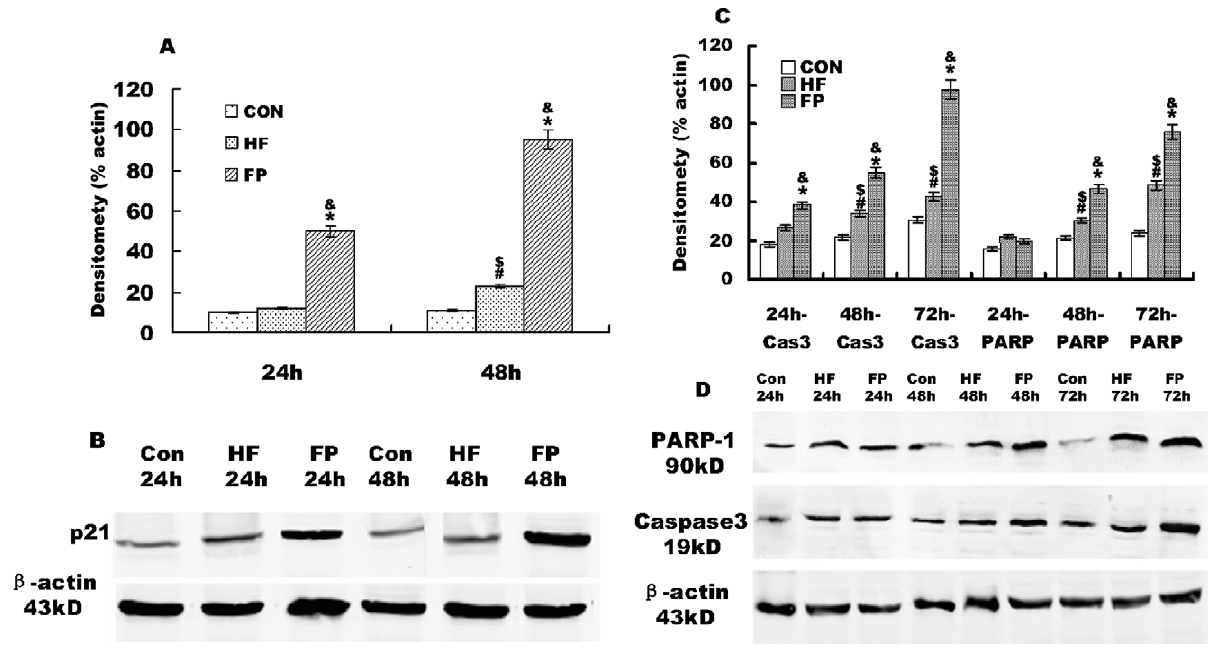
Figure 5. Effects of HF and FP on p21, caspase-3, and PARP in Hela cells by western blotting analyses. A) Histogram representing p21. B) Representative western blots of p21/Waf1 in FP, HF and control groups after 24 and 48 h. C) Histogram representing cleaved caspase-3 (19 kD) and cleaved PARP-1 (90 kD). D) Representative western blots of cleaved caspase-3 and cleaved PARP-I in the FP, HF and control groups after 24, 48 and 72 h. Total extracts obtained from HeLa cells without HF or FP treatment (Con), with 20 m M HF treatment (HF) and with 20 m M FP treatment (FP) were subjected to western blot analysis as described in Materials and Methods. The densitometry measurements represent the amount of p21, caspase 3, and PARP1 relative to b -actin and are given as means from triplicate experiments expressed as % of b -actin 6 SE. b -actin was used as a loading control. * p , 0.001 versus control cells; # p , 0.01 versus control group; $ p , 0.01 versus FP group; & p , 0.01 versus HF group.